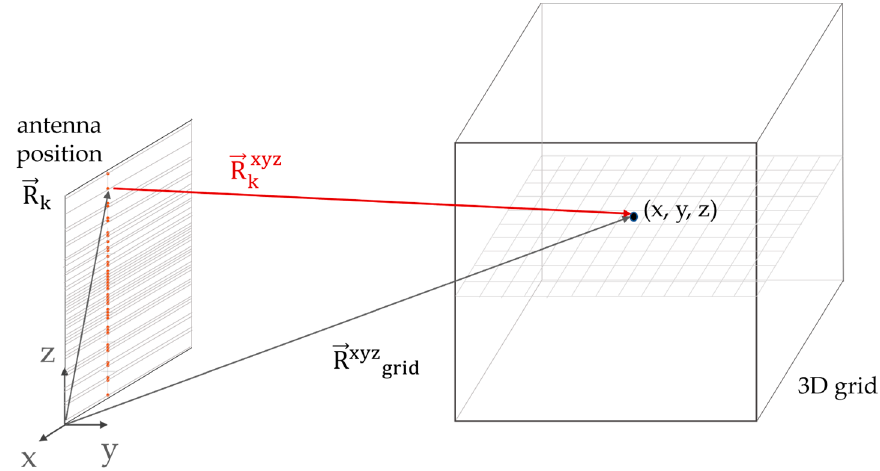
Figure 6. Geometry of the three-dimensional focalization algorithm.